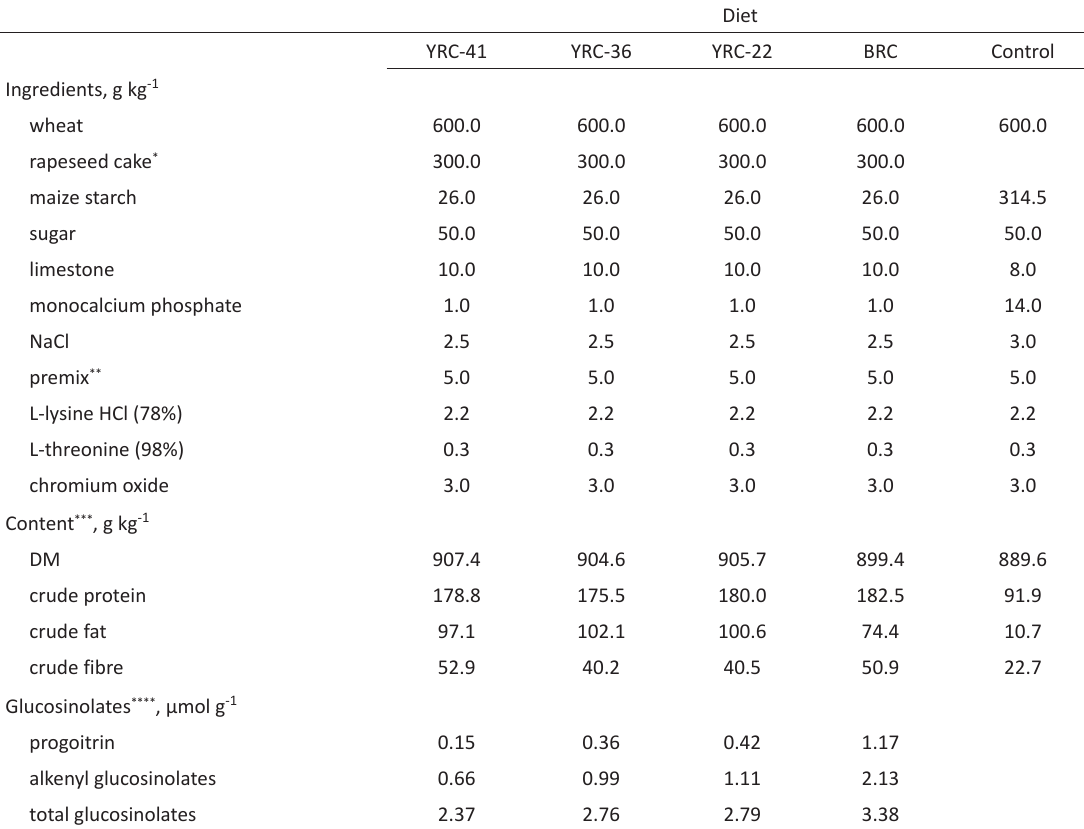
Table 1. Composition of diets used in Experiment